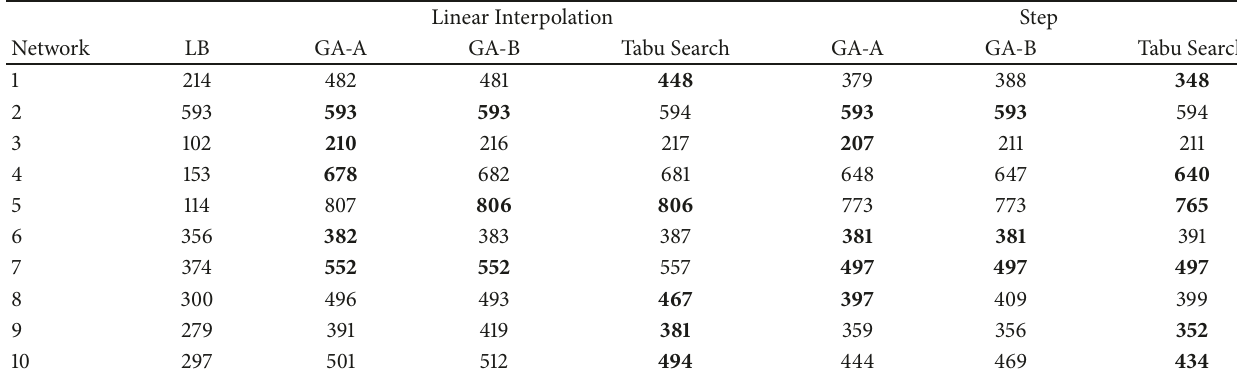
Table 4: Results for size 50 networks.